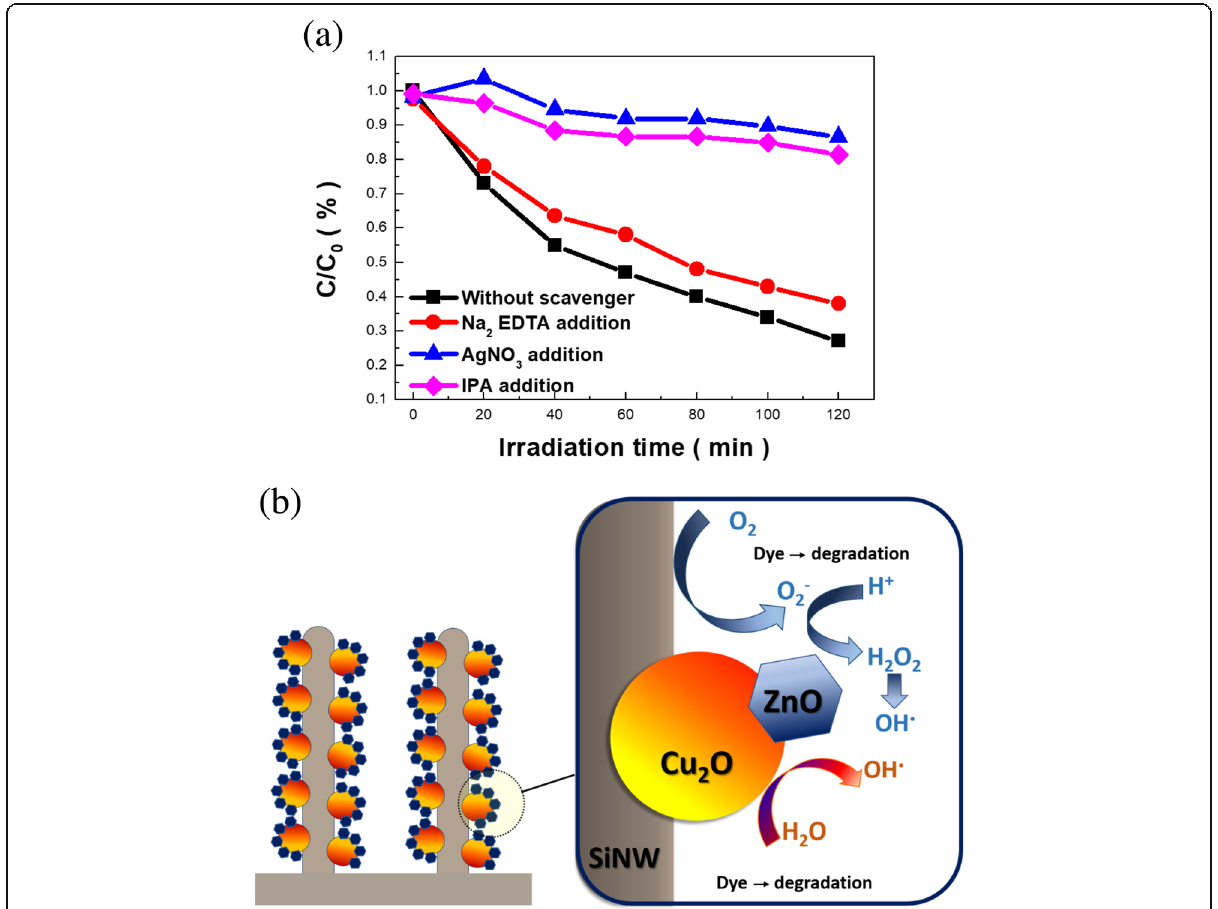
Fig. 6 a Scavenging analysis of photodegradation process in the presence of ZCS nanowires. b Schematic illustration for the photocatalytic mechanism on dye degradation under ZCS heterostructure-based